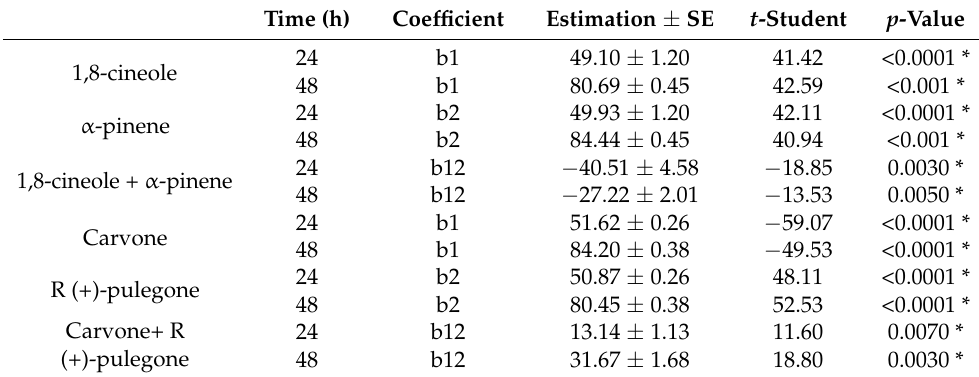
Table 5. Estimated regression coefficients for the incomplete cube regression